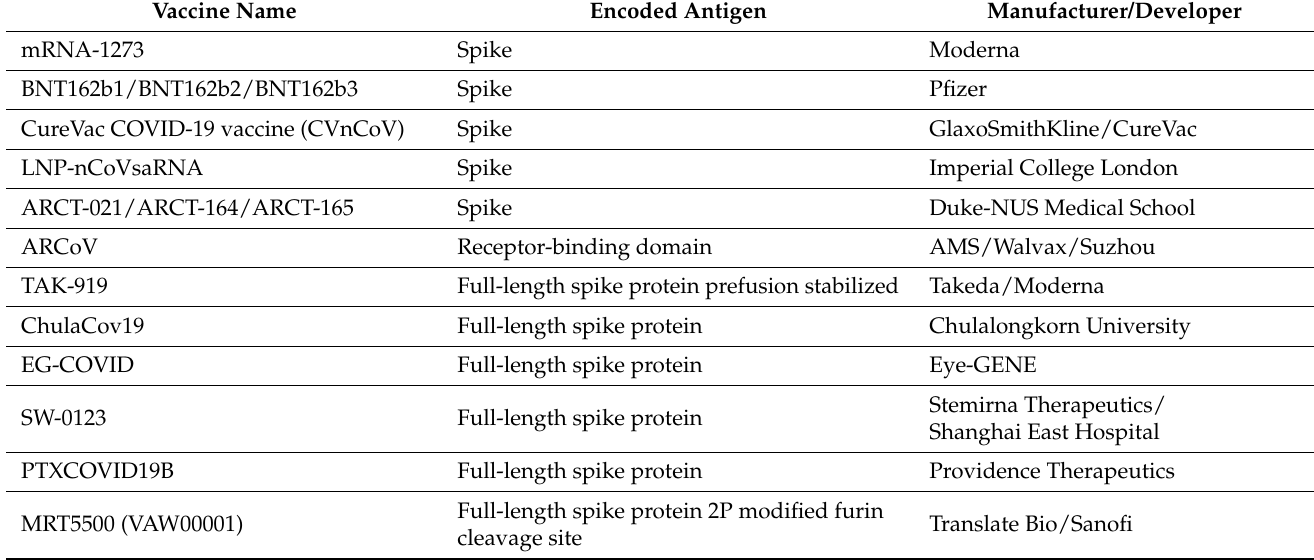
Table 3. Lipid nanoparticle mRNA vaccines against